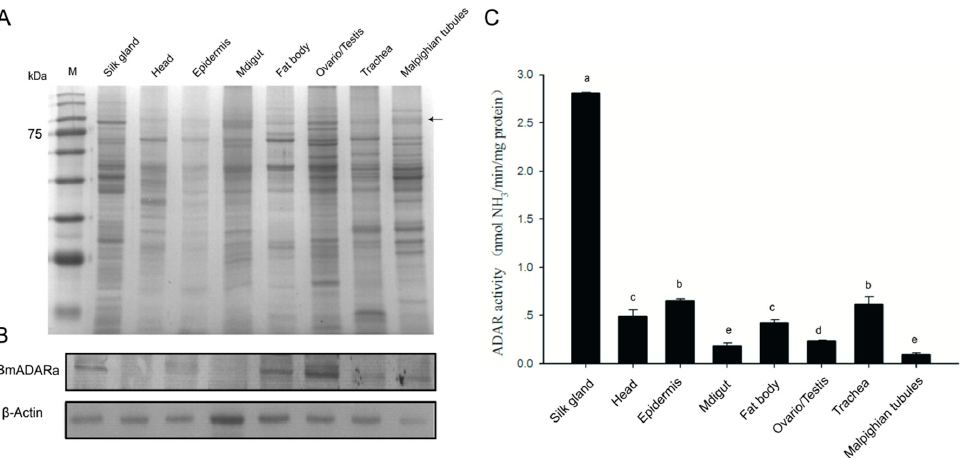
Figure 2. Identification of BmADARa expression and adenosine deaminase activity in the silkworm larval tissues. Ten milligrams of each tissue protein from day 3 fifth instar larvae were analyzed by SDS-PAGE ( A ) and Western blot ( B ) using anti-BmADARa antiserum. Arrow at the right shows the approximate position of BmADARa. BmActin was used as the control. Vertical bars indicate the mean ± SEM (n = 3). In addition, adenosine deaminase activity in 10 mg of total tissue proteins was determined ( C ). Bars represent the mean ± SD of at least five independent experiments performed in triplicate. Significance difference is shown between two alphabets (one-way ANOVA, followed by Tukey’s test as post hoc). The specific enzyme activity is shown as nmol of NH 3 min − 1 mg − 1 of protein.